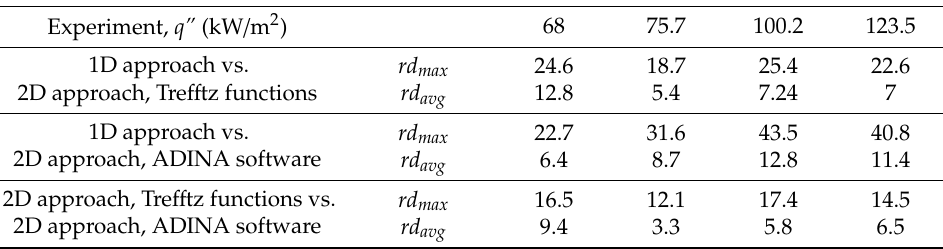
Table 5. The values of the maximum ( rd max ) and average ( rd avg ) relative di ff erences between heat transfer coe ffi cients obtained using the 1D approach and 2D approach (applying the Tre ff tz functions and ADINA software), the data for the test section with three